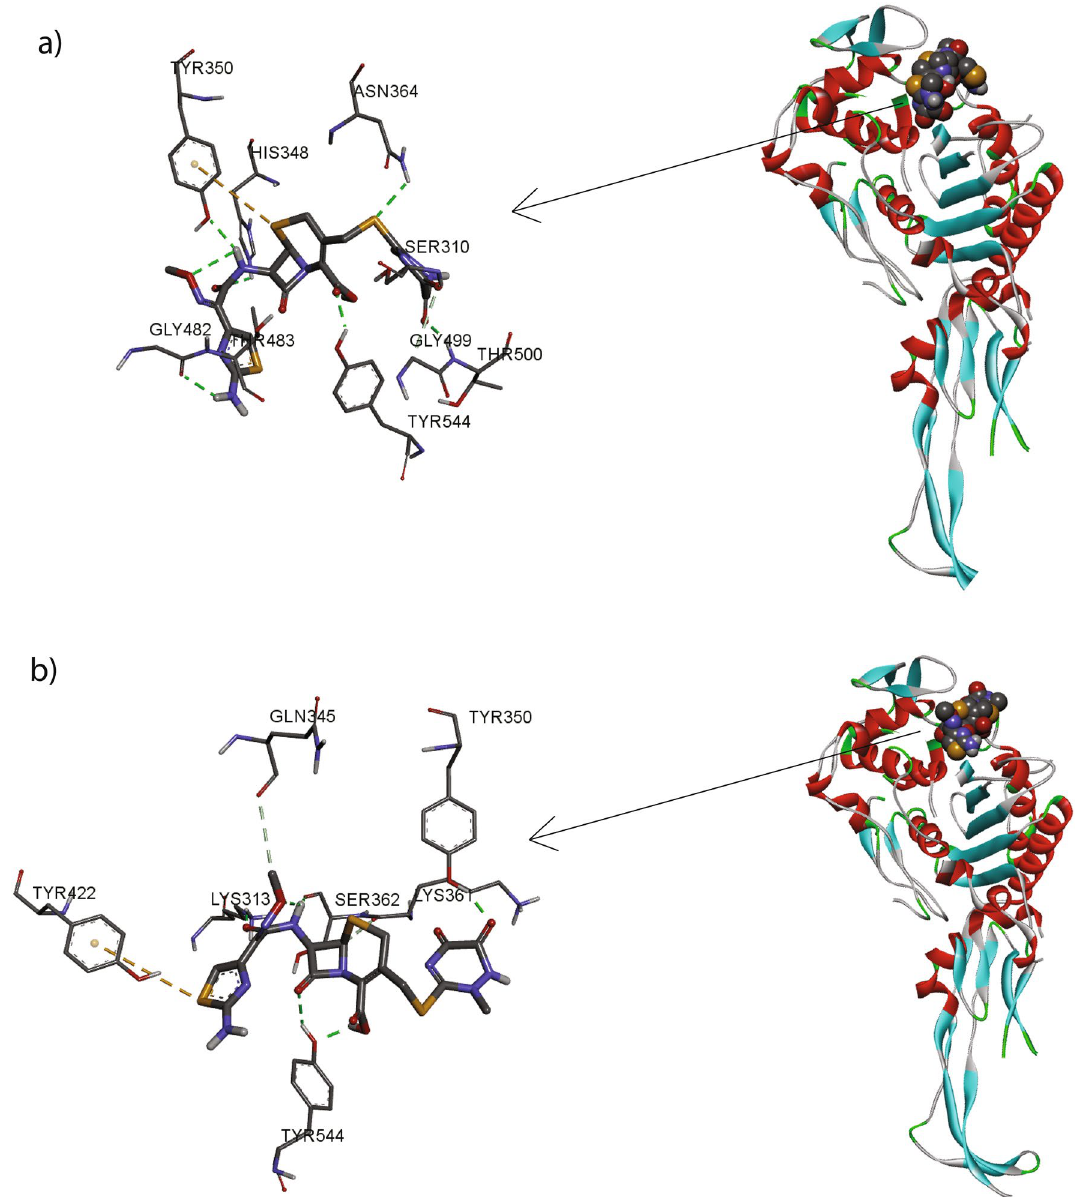
Figure 3. Molecular docking of ceftriaxone in the active site of a) wild type PBP2 and b) mosaic XXXIV PBP2 variant. The standard macromolecule was extracted from rcsb.org/ (PDB: 3EQU) and the mutations were modeled by PyMOL [DeLano, 2002] (The PyMOL Molecular Graphics System, Version 1.2r3pre, Schrödinger,